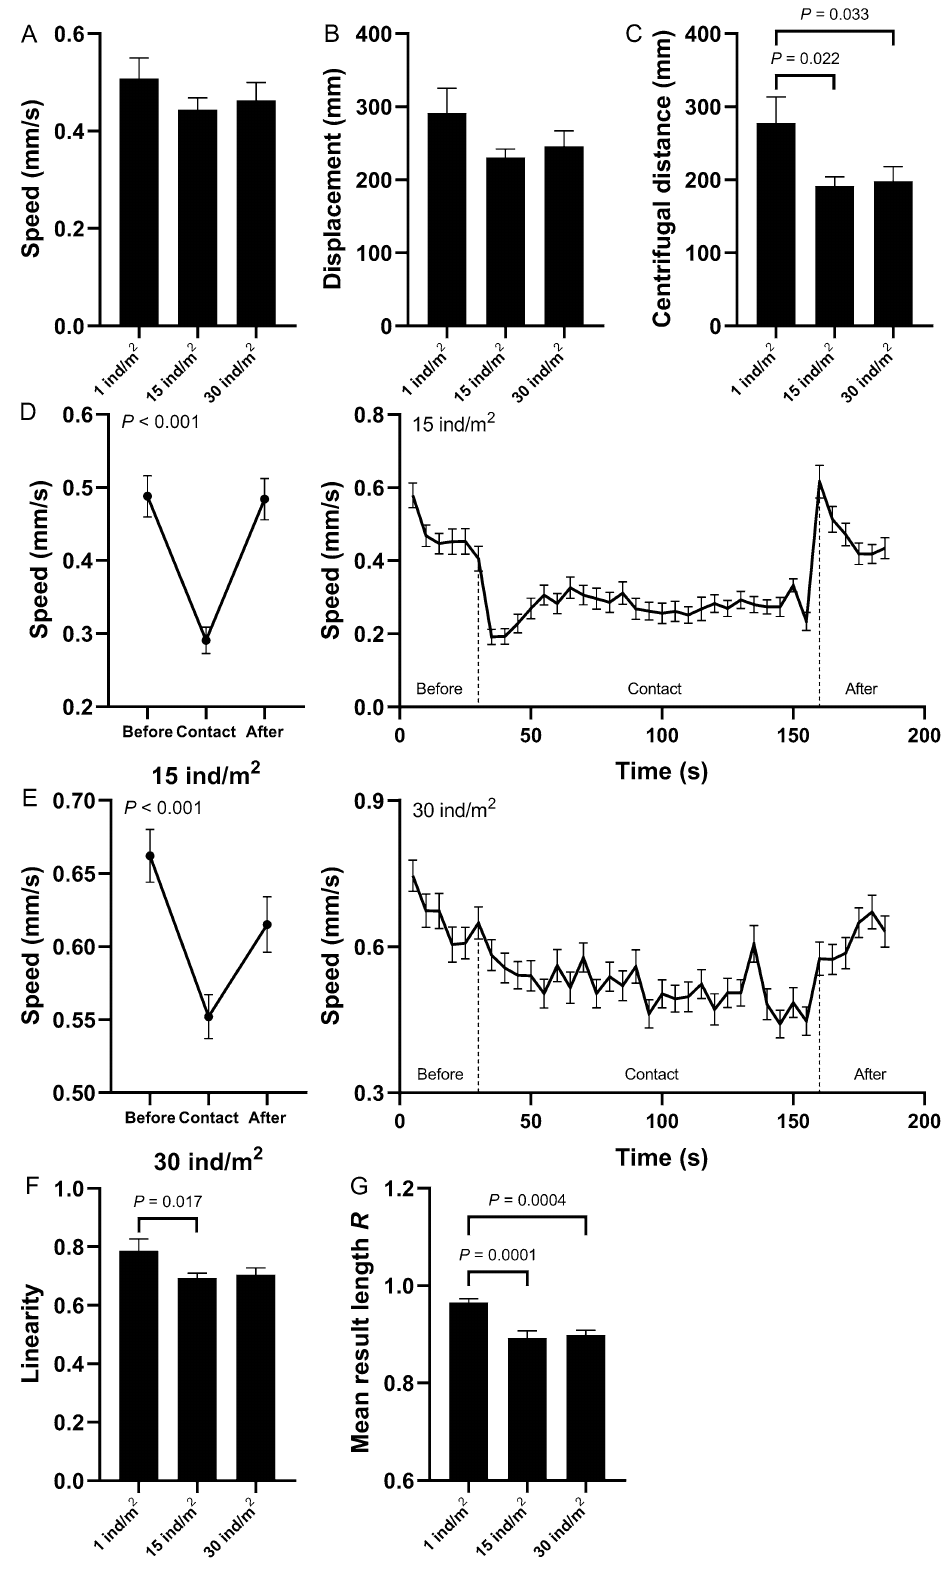
Figure 1. Behavioral changes (mean ± SEM) of sea urchins when they randomly contacted conspecifics in different density groups without the food cues. Movement speed, displacement and centrifugal distance of sea urchins in the 1, 15 and 30 ind/ m 2 groups without the food cues ( A – C ). Speed of sea urchins before, during and after the contacts in 15 ind/m 2 ( D , left) and the speed per 5 s ( D , right). Speed of sea urchins before, during and after contact in 30 ind/m 2 ( E , left) and the speed per five seconds ( E , right). Movement linearity and mean result length R of sea urchins in 1, 15 and 30 ind/m 2 without the food cues ( F , G